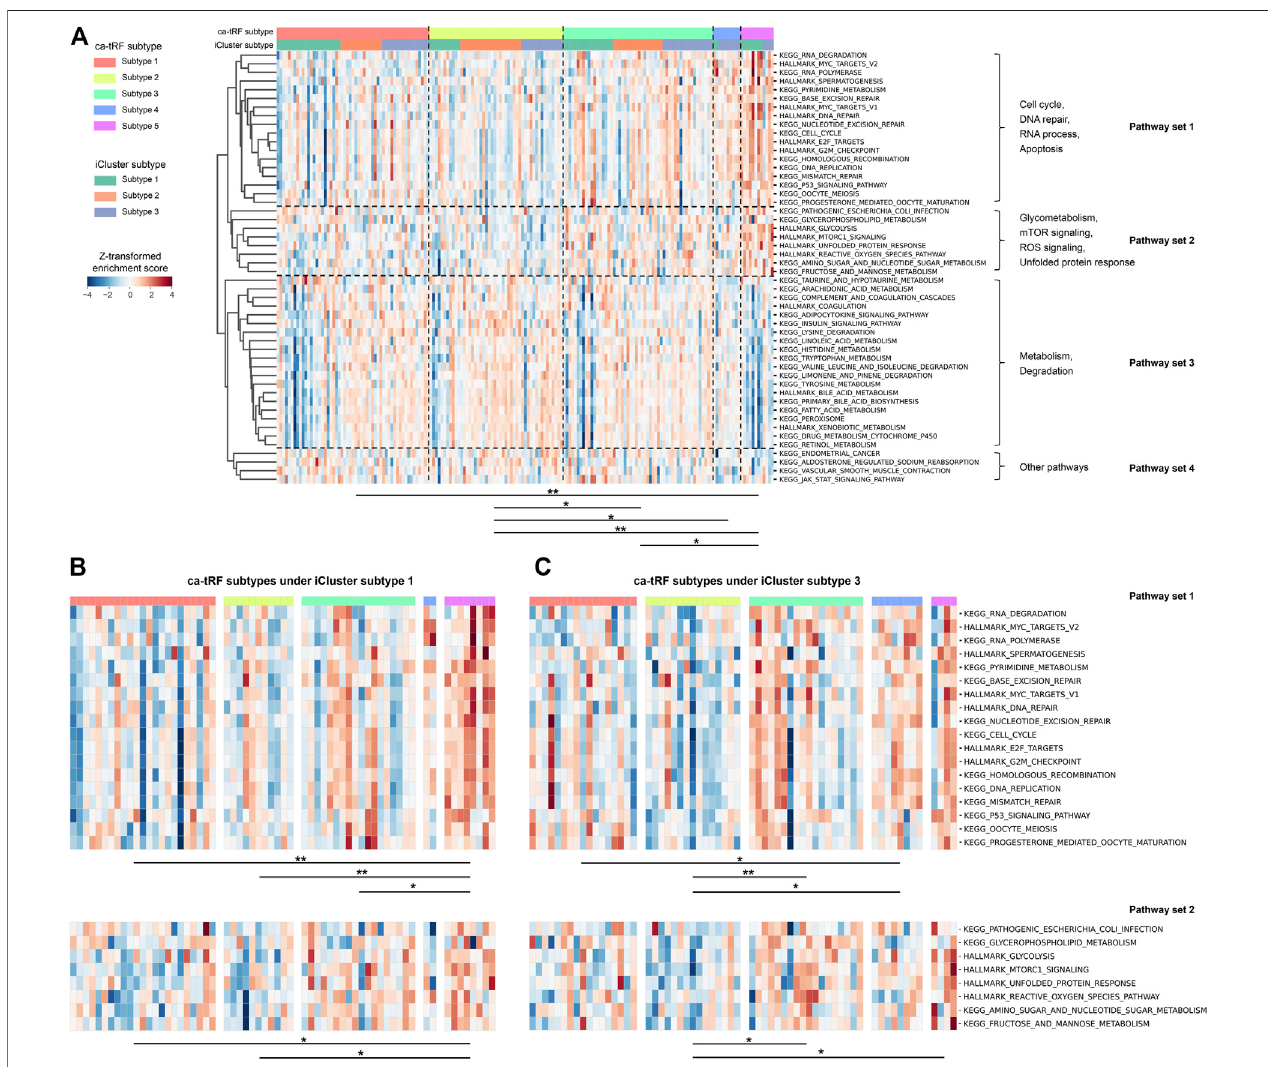
FIGURE 10 | Distinct activities of biological pathways in LIHC revealed by ca-tRF-based subtyping regardless of the multi-omics characteristics-based iCluster subtypes 1 and 3. (A) Heatmap showing the enrichment scores (ES) of 50 most variable biological pathways among LIHC ca-tRF-based subtypes. The ca-tRF subtype and iCluster subtype assignments of each sample are indicated by the color stripes above the heatmap. The pathways could be clustered into four pathway sets, as annotatedontherightsideoftheheatmap. (B) HeatmapshowingtheESsofpathwayset1and2among fi veca-tRFsubtypesunderspeci fi ciClustersubtype1. (C) HeatmapshowingtheESsofpathwayset1and2among fi veca-tRFsubtypesunderspeci fi ciClustersubtype3.Forallpanels,pairwiseEScomparisonresultsbetween ca-tRF subtypes are shown under the heatmap (Mann-Whitney test, * p -value < 0.05, ** p -value < 0.01).